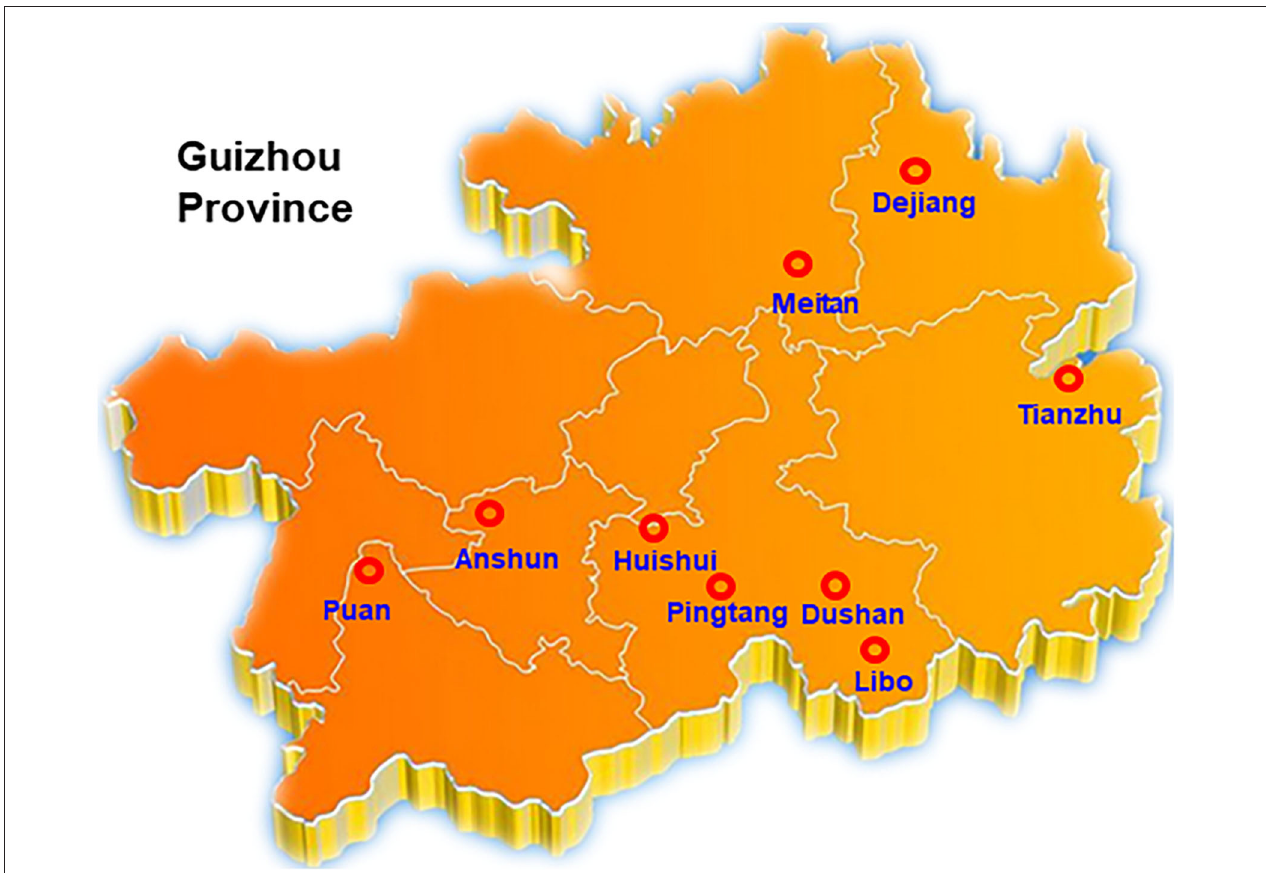
FIGURE 1 | Investigation and collection of SRBSDV in Guizhou Province. Rice samples from Tianzhu, Meitan, Dejiang, Puan, Libo, Pingtang, Huishui, Dushan, and Anshun 9 districts of Guizhou were selected in this